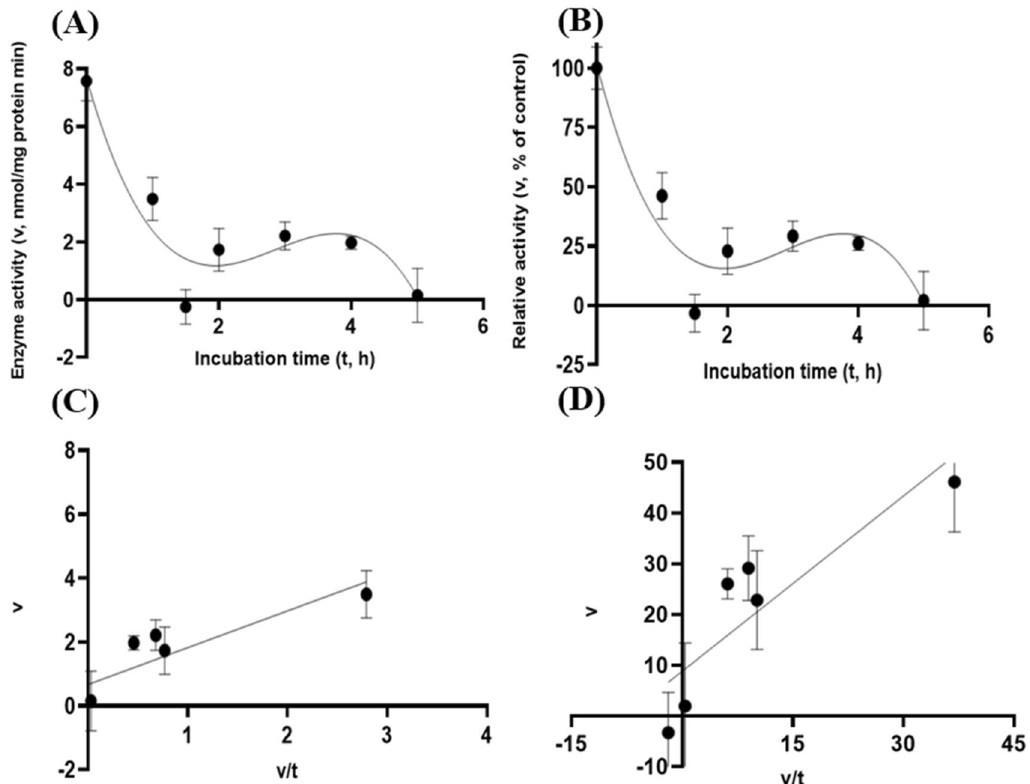
Figure 15. Experiment-3 of the intestinal pancreatic chymotrypsin (20 U/mL) effects (with describing model parameter estimates ± SE ) on GH5-tCel5A1 activity over a 5-h period after the intestinal pancreatic chymotrypsin buffer being mixed with the GH5-tCel5A1 enzyme preparation for incubation at the resulting mixture pH = 6.0–7.0 and chymotrypsin (20 U/mL) prior to further incubation for measuring cellulase activity with the carboxymethyl cellulose (CMC) substrate buffer in presence of dithiothreitol (DTT) (5 mM) and N 2 gas purging for 15 min at 37 °C. (A) Plot of the inhibition kinetic relationship between the GH5-tCel5A1 activity (v, mean ± SE, n = 12at each time point, nmol/mg protein•min) and incubation time (t, h) under the chymotrypsin (20 U/mL) condition established according to the cubic response model as: Y = 9.908 ( ± 0.983 ) − 9.709 ( ± 1.517 ) x + 3.416 ( ± 0.659 ) x 2 − 0.366 ( ± 0.079 ) x 3 , P < 0.0001 for all parameter estimates; R 2 = 0.469 , n = 84; and alternatively according to the linear response model as: y = 4.828 ( ± 0.609 ) − 0.942 ( ± 0.197 ) x , P < 0.0001 for all parameter estimates; r 2 = 0.224 , n = 84; (B) Plot of the inhibition kinetic relationship between the relative GH5-tCel5A1 activity (v, mean ± SE, n = 12at each time point, % of the control group measured at I c of 100.000 ± 9.944) at 0-min exposure to the chymotrypsin-20-U/mL incubation) and incubation time (t, h) chymotrypsin according to the cubic response model established as: Y = 130.8 ( ± 12.982 ) − 128.2 ( ± 20.030 ) x + 45.105 ( ± 8.698 ) x 2 − 4.836 ( ± 1.055 ) x 3 , P < 0.0001 for all the parameter estimates; R 2 = 0.471 , n = 84; and alternatively according to the linear response model as: y = 63.742 ( ± 8.034 ) − 12.439 ( ± 2.602 ) x , P < 0.0001 for all parameter estimates; r 2 = 0.225 , n = 84; (C ) the Eadie-Hofstee linear plot between the tCel5A1 enzyme activity (v, mean ± SE, n = 12at each data point, nmol/mg protein•min) and the v/t ratio established as: y = 0.365 ( ± 0.172 ) + 1.592 ( ± 0.115 ) x , P = 0.037 for the intercept; and P < 0.0001 for the slope; r 2 = 0.746 , n = 72; and (D ) the Eadie-Hofstee linear plot between the relative GH5-tCel5A1 enzyme activity (v, mean ± SE, n = 12at each data point, % of the control group measured at I c of 100.000 ± 9.944) at 0-min exposure to the chymotrypsin-20-U/mL incubation) and the v/t ratio established as: y = 4.822 ( ± 2.268 ) + 1.592 ( ± 0.115 ) x , P = 0.037 for the intercept; and P < 0.0001 for the slope, r 2 = 0.746 , n = Protein expression. The AA sequence of tCel5A1 (GenBank #:AAD36816.1) was obtained from the origi- nal research work by Basit and Akhtar 25 . The nucleotide coding sequence of GH5-tCel5A1 was codon-optimized for over-expression in E. Coli and was commercially synthesized by Integrated DNA technologies as a gene block (Coralville, Iowa, USA). The GH5-tCel5A1 gene block was then ligated into the vector p15TV-L (acces- sion number EF456736) and fused in frame with an N-terminal His-tag for generating p15TV-L-tCel5A1 as described by Wang et al. 11 . The construct was then verified by DNA sequencing at the University of Guelph Laboratory Service Molecular Super Center. This plasmid construct was then transformed into the CLEARCOLI BL21 (DE3) electrocompetent cells using the standard protocols by following our previously reported work by Wang et al. 11 .